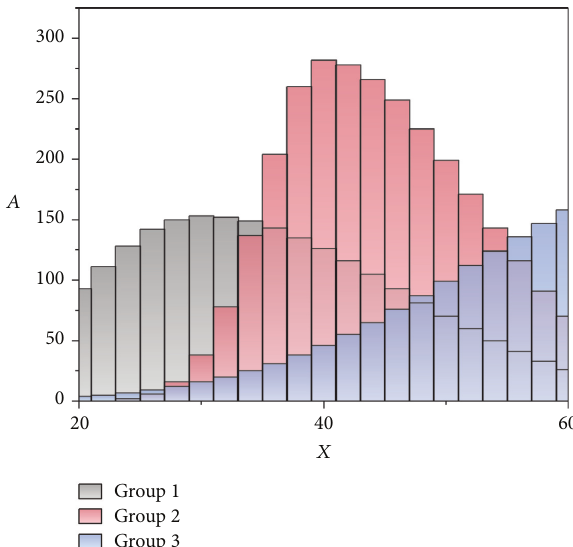
Figure 5: A-values for different X